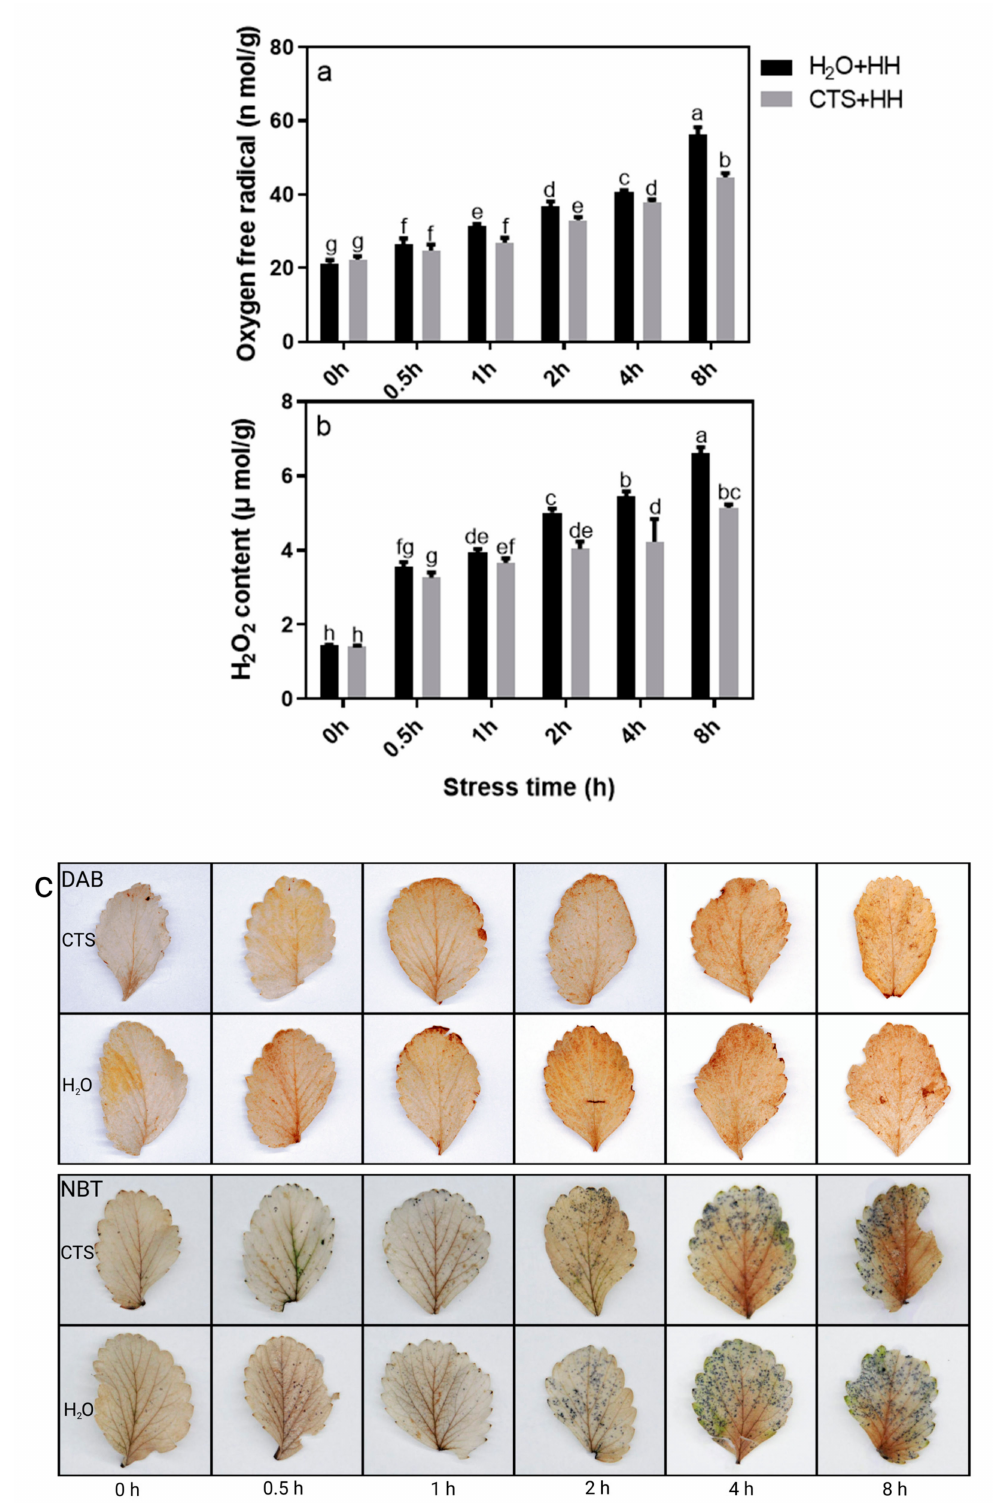
Figure 5. Effect of CTS on the H 2 O 2 and O 2 − contents of strawberry seedlings under high-temperature and high-light stress. ( a ) O 2 − content; ( b ) H 2 O 2 content; ( c ) tissues were stained for H 2 O 2 and O 2 − using 3,3 (cid:48) -diaminobenzidine (DAB) and nitro blue tetrazolium (NBT). CK: H 2 O + 23 ◦ C + 400 µ mol · m − 2 · s − 1 ; H 2 O + HH: H 2 O + 38 ◦ C + 1800 µ mol · m − 2 · s − 1 ; CTS + HH: CTS + 38 ◦ C + 1800 µ mol · m − 2 · s − 1 . The different lowercase letters indicate significant differences between the treatments (Duncan’s multiple range test; p <